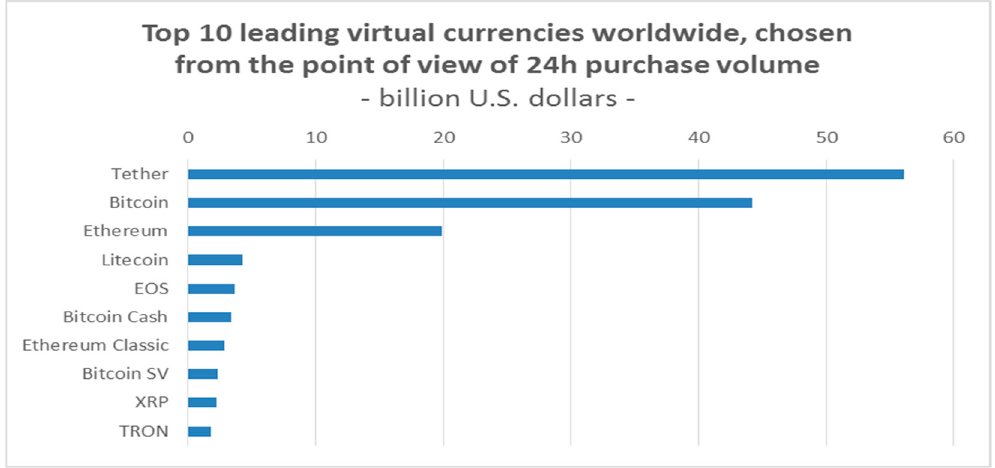
Figure 3. Top 10 leading virtual currencies worldwide. Source: Authors’ own processing based on Statista data.